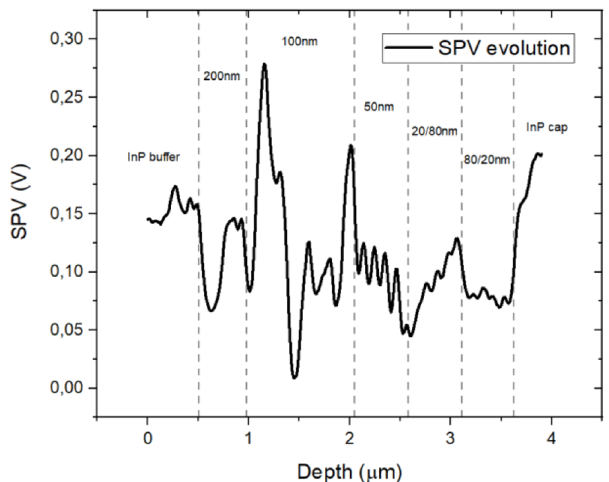
Fig. 9. SPV evolution along the structure calculated from the dark and light pro fi les showed in Figure 6a applying